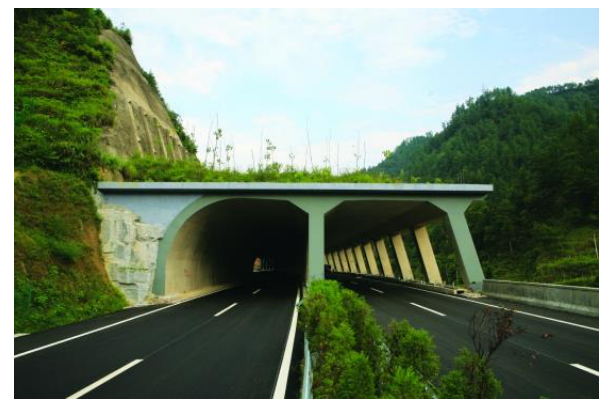
Fig. 2. Flexible rock shed composed of steel vaulted structure and flexible nets 1. Steel vaulted structure; 2. Flexible nets; 3. Longitudinal support cable; 4.Net-hanging bracket; 5. Hoop support cable; 6. Cable anchor; 7. Anchor bolt; 8. Ground